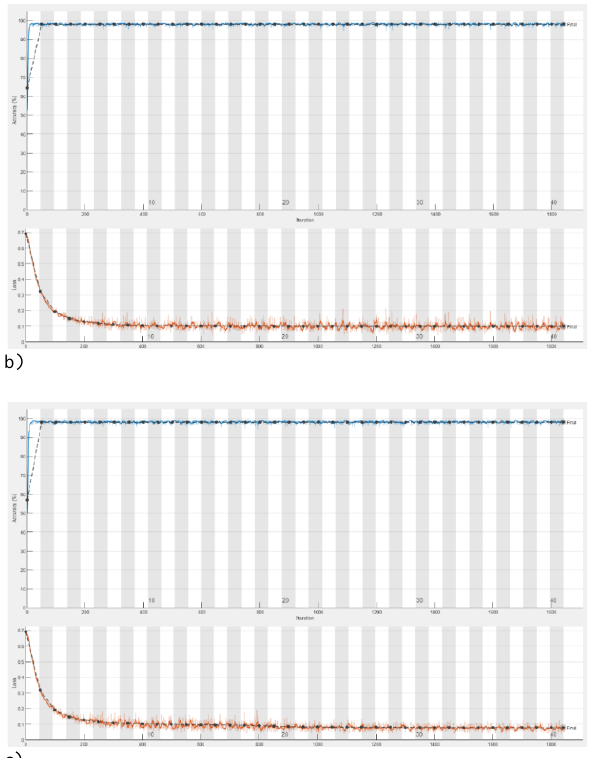
Fig. 6. TA-SegNET accuracy and loss function for data set-1: a) Training; b) Validation; c) Testing.